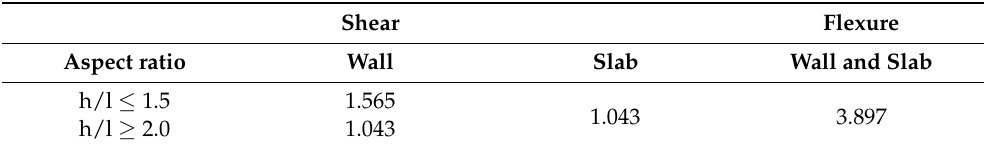
Table 2. Cracking strength of concrete (MPa).